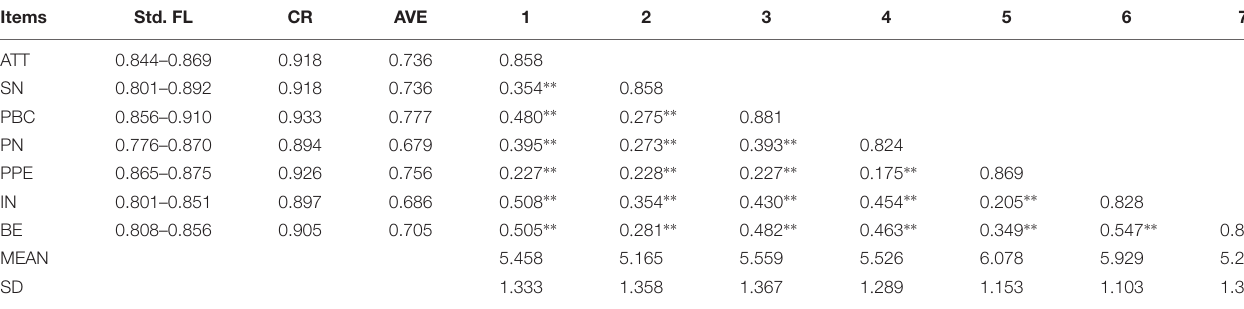
TABLE 3 | Confirmatory factor analysis for the survey instrument validity and reliability.